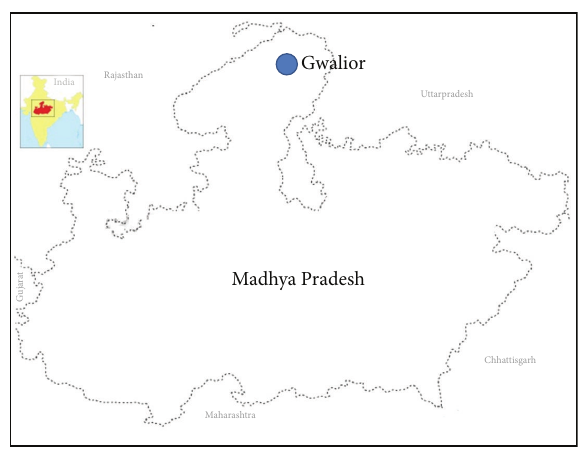
Figure 1: Map of the state of Madhya Pradesh, India, showing the location of Chikungunya affected